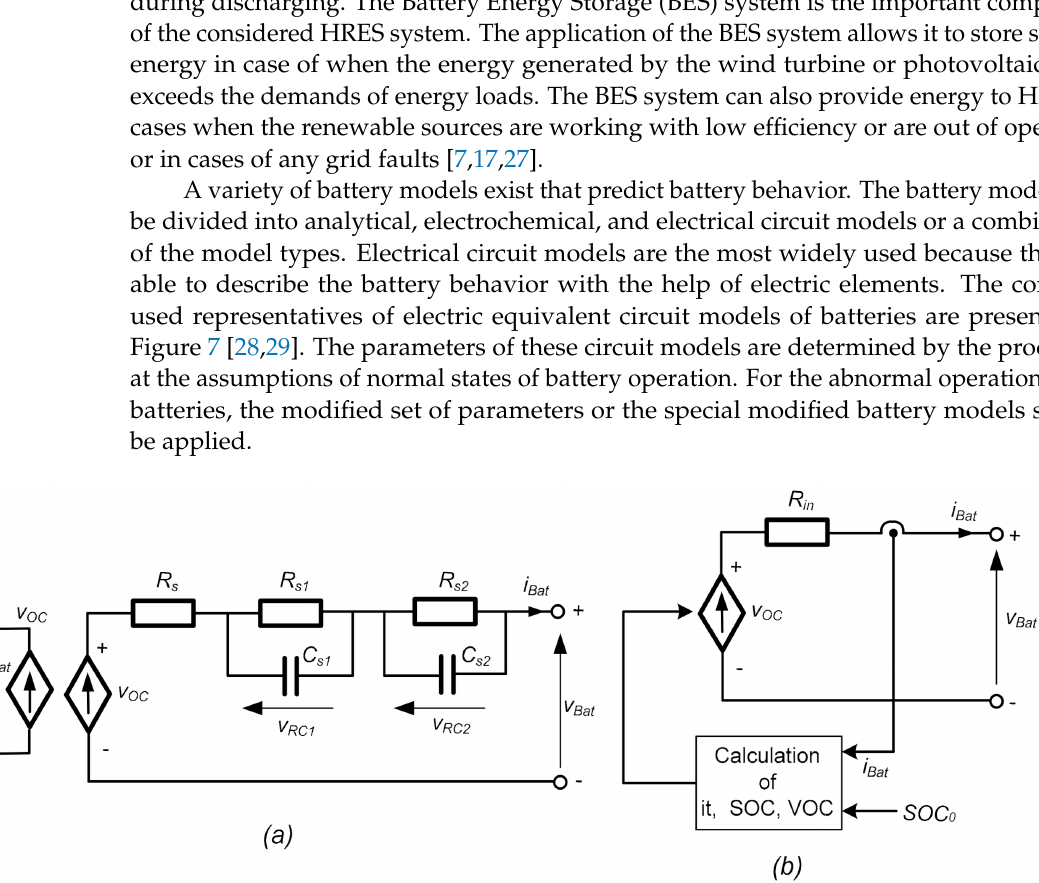
Figure 7. The electric equivalent circuits for batteries: ( a ) Dynamic model with 2 RC networks (Runtime-based model); ( b ) nonlinear circuit model (Shepherd’s